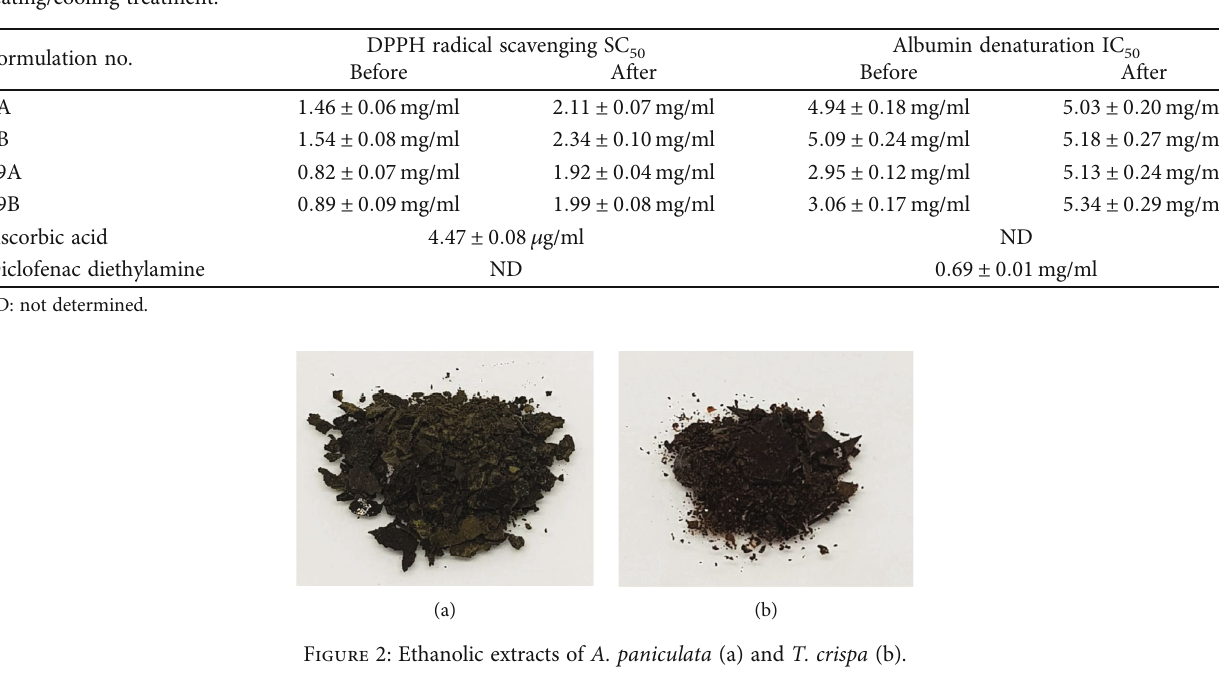
Table 7: DPPH free radical scavenging and protein denaturation inhibitory activities of developed nail lacquers before and after six cycles of heating/cooling treatment.